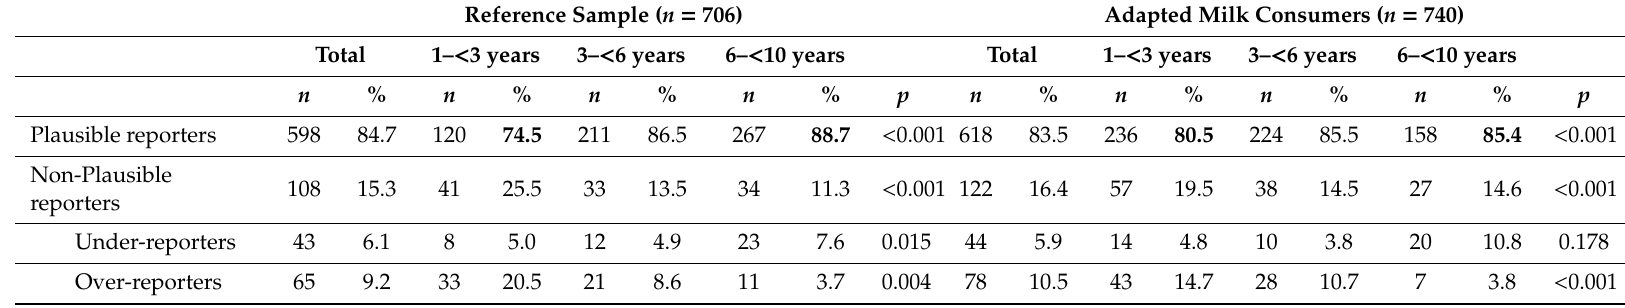
Table 6. Percentages of under-reporters, plausible and over-reporters of energy intake in the Nutritional Study in Spanish Pediatric Population (EsNuPI) (number and percentages) ( n = 1446)